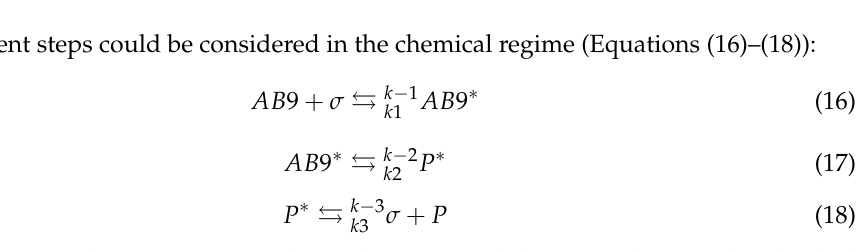
Table 2. k obs as a function of the particle sizes of ZnO. Comparison with the various inhibitions. 0.01 < p < 0.05 for Z30-Ps vs. Z25-Ps and for Z30-Ps vs. Z9-Ps.